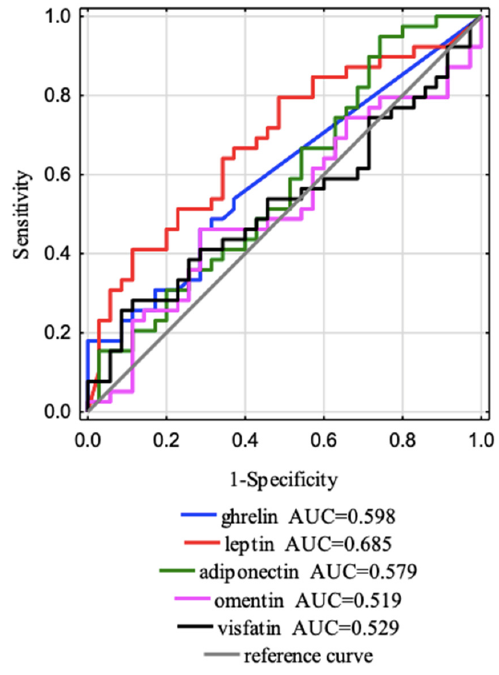
Figure 5. Five ROC curves and AUC values of the adipokines studied were designed to distinguish factors that affect vitamin D concentration (cut-off point 18.5 ng/mL). Table 6. Results of diagnostic accuracy for the prediction of vitamin D fluctuation.